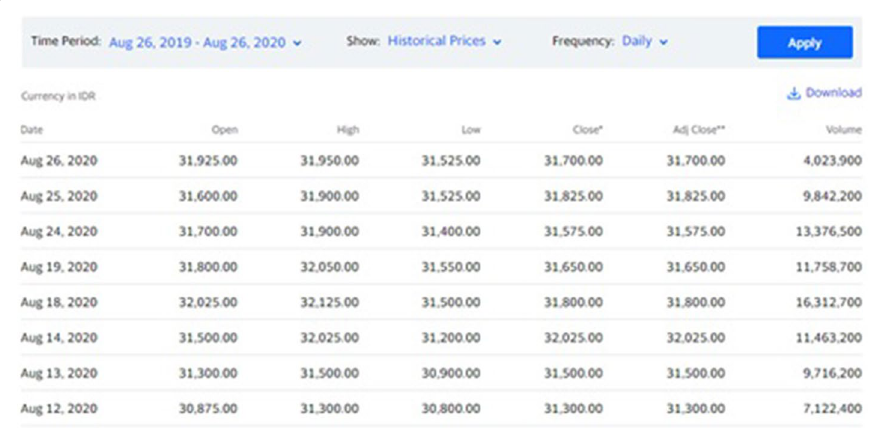
Fig. 1 Example of datasheet from Yahoo Finance